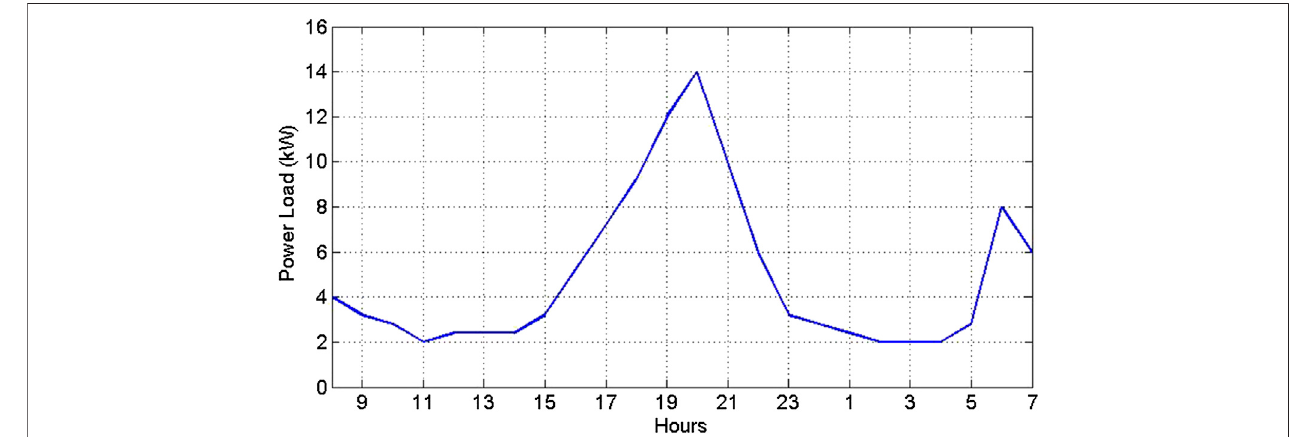
FIGURE 1 | Expected total electrical